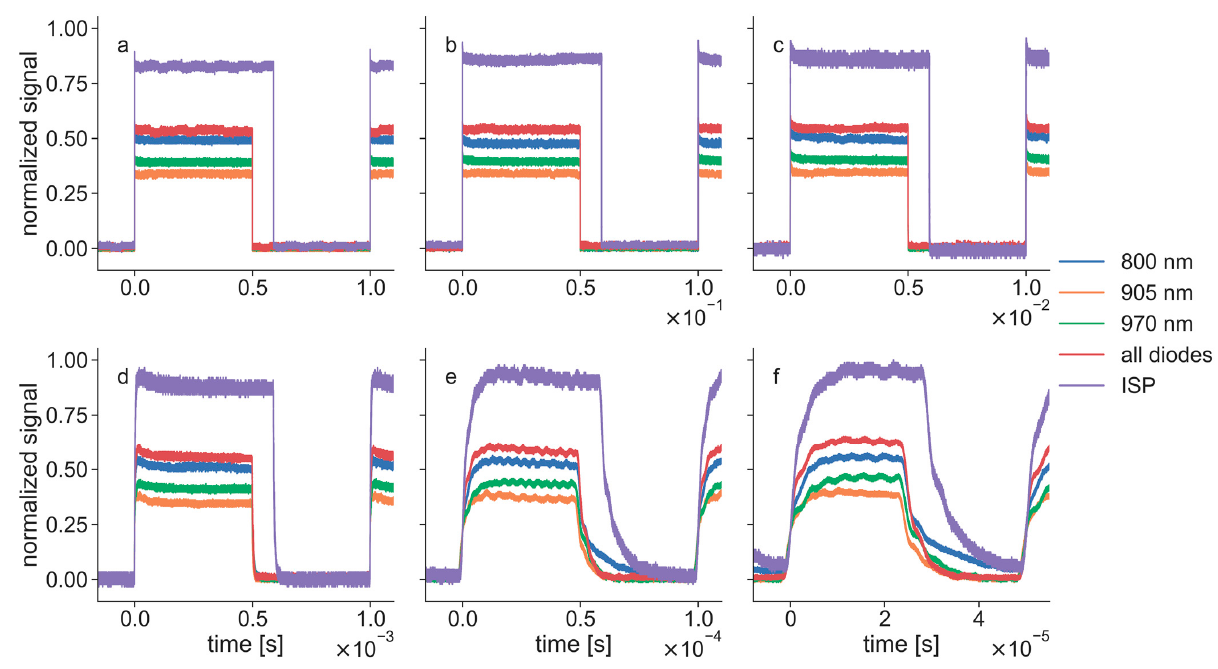
Figure 7. Light intensity in time for K-1 in the pulsed wave (PW) mode at different repetition rates: ( a ) 1 Hz; ( b ) 10 Hz; ( c ) 100 Hz; ( d ) 1 kHz; ( e ) 10 kHz; ( f ) 20 kHz. Pulses were recorded using the three diodes (800 nm, 905 nm, 970 nm) individually, all diodes simultaneously and using the K-lasers’ intense super pulse (ISP) mode. All measurements were done with K-1 set to maximum average power. The signals were normalized to the maximum value of each repetition rate.